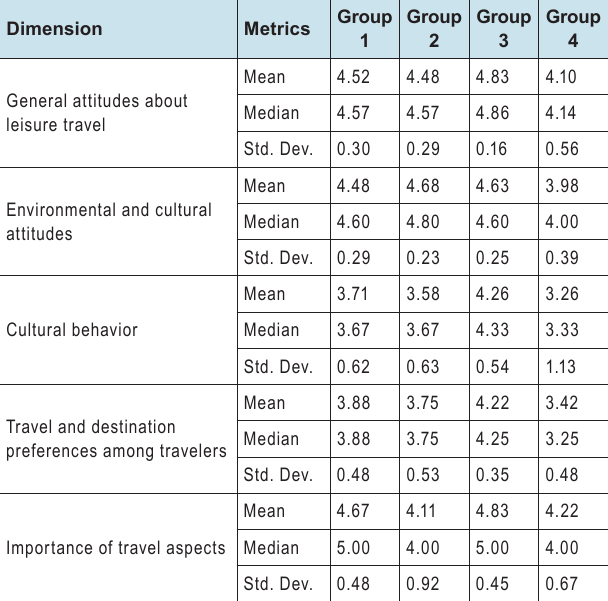
TABLE 3 . Mean, median, and standard deviation of attitudes, behaviors, preferences, and importance of travel per group in the territory of the Serra do Sincorá Geopark Project, Lençóis, Bahia.